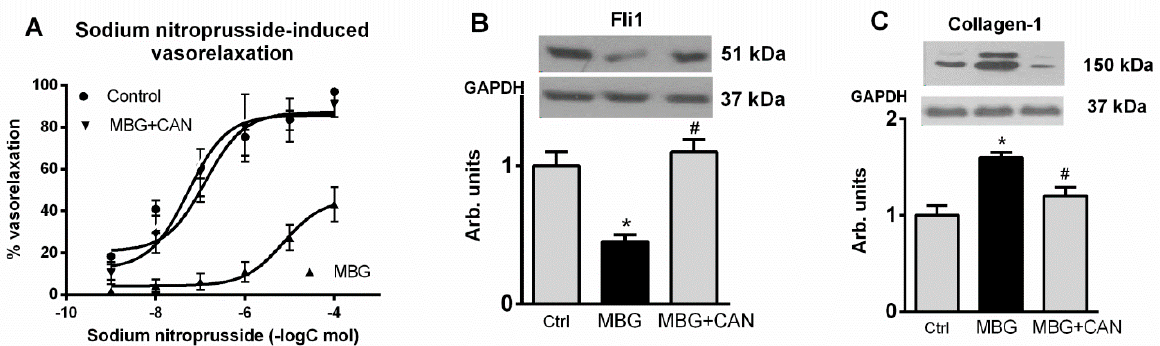
Figure 6. ( A )—Effect of the normotensive pregnancy, control (60 ± 15 nmol/L), normotensive pregnancy in the presence MBG (1.1 ± 30 µ mol/L; p < 0.01 vs. contol), and normotensive pregnancy in the presence of MBG and canrenone (EC 50 = 7.9 ± 2.8 nmol/L, p < 0.01 vs. effect of MBG) on the responsiveness of umbilical artery rings to sodium nitroprusside-induced vasorelaxation following contractions induced by 100 nmol/L endothelin-1. Concentration–response curves were determined 5 times and averaged to give means and SEM for IC 50 . Effects of the normotensive pregnancy (Ctrl), PE (Nontr) and PE plus canrenone (Can) on ( B ) levels of Fli1 and ( C ) collagen-1 in umbilical arteries. Top panels, Western blotting representative bands; bottom panels, GAPDH for statistical analysis. Each bar represents individual samples pooled and averaged to give means and SEM of 5 measurements. By one-way ANOVA followed by Bonferroni test: * p < 0.01 versus nontr. # p < 0.01 vs. can.